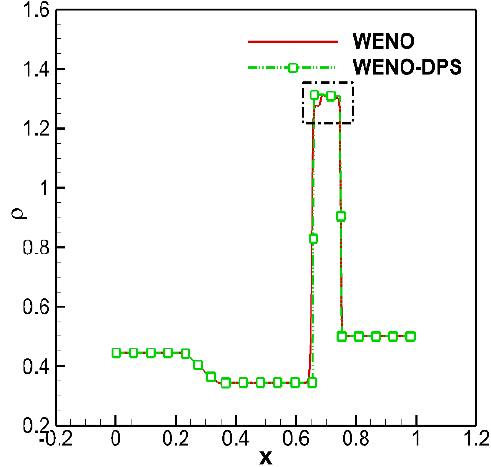
Figure 12. Zoomed view of density plot of Lax test case with 20 s t